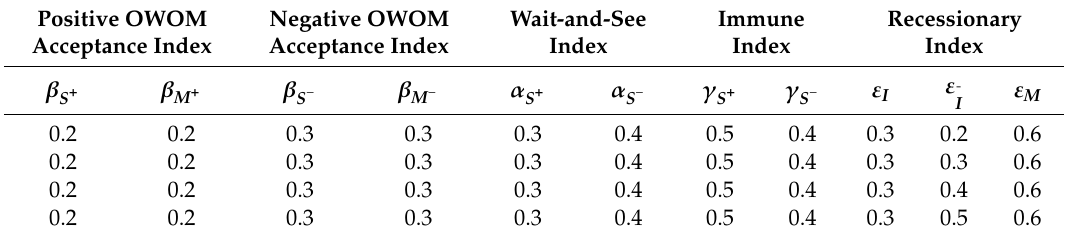
Table 8. Simulation Experiment 5 parameter setting.